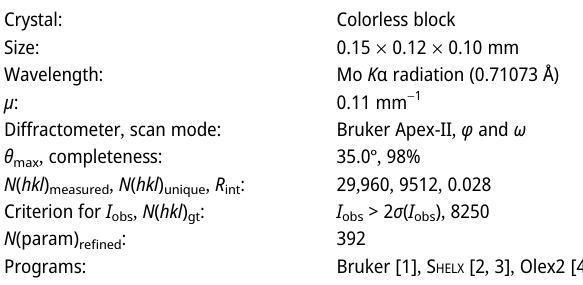
Table  : Data collection and